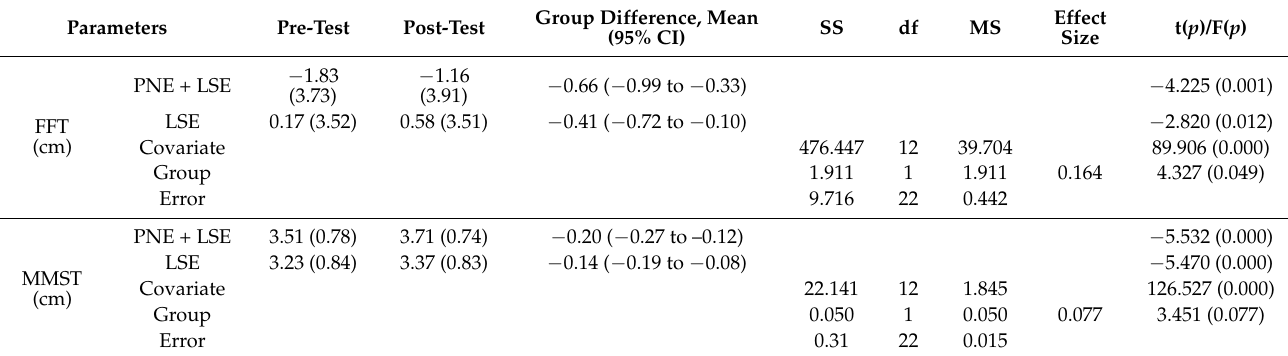
Table 6. Comparison of flexibility within groups and between groups ( N = 35).